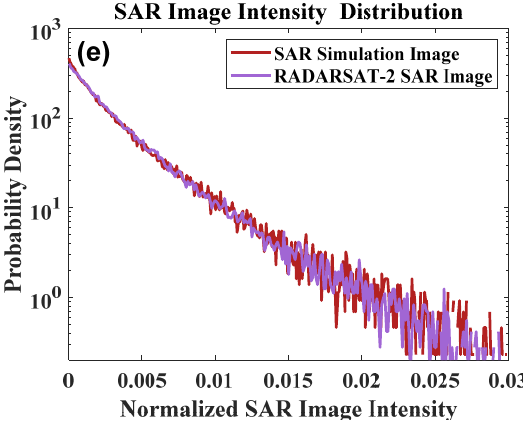
Figure 5. Same as in Figure 3, but for SAR ID 3.